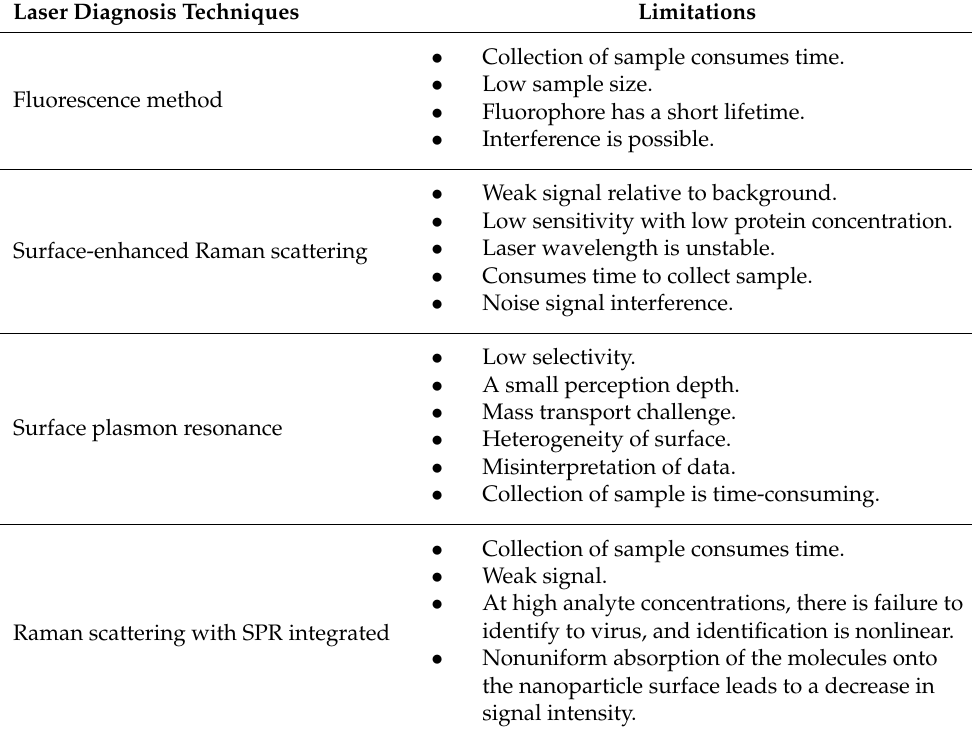
Table 3. The challenges of laser diagnosis techniques of COVID-19. Laser Diagnosis